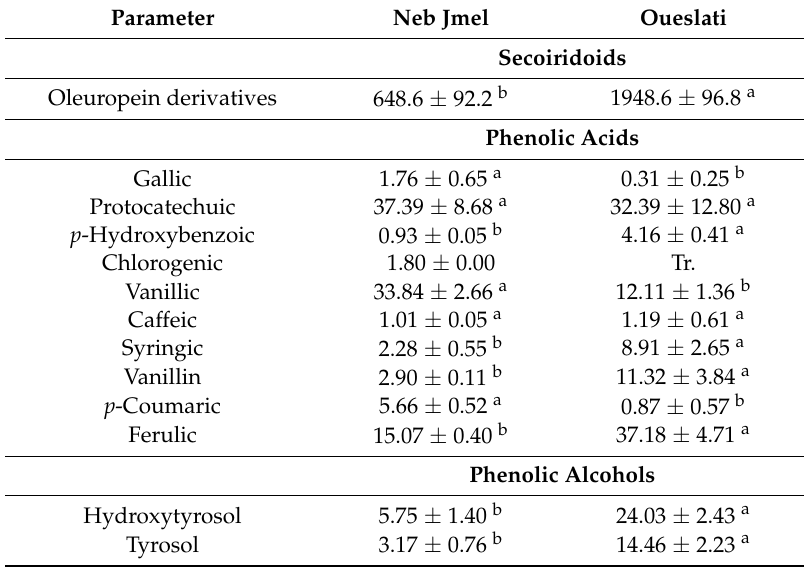
Table 3. Phenolic compounds ( µ g/g DW) of Neb Jmel and Oueslati olive leaves.